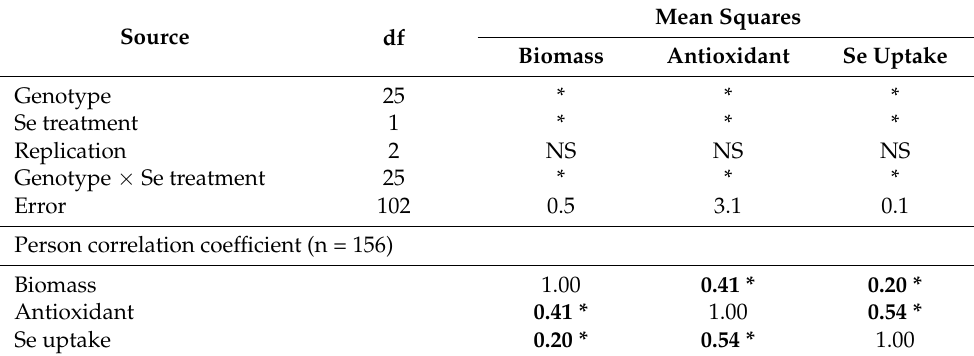
Table 3. Combined analysis of variance for 26 lentil genotypes during germination with response to Se fertilizer. Mean Squares Source df Biomass Antioxidant Se Uptake